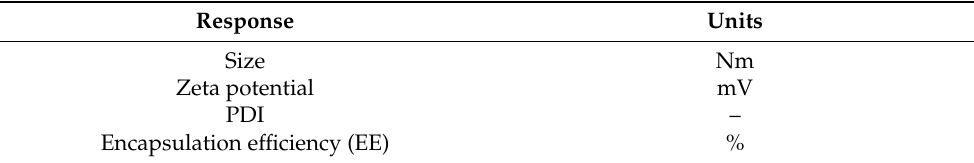
Table 2. Dependent variables selected in the optimization